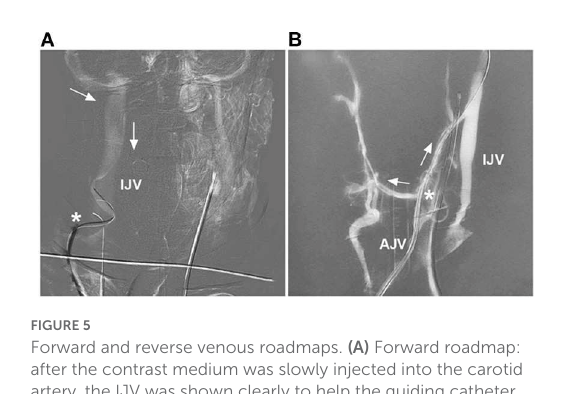
FIGURE5 Forward and reverse venous roadmaps. (A) Forward roadmap: after the contrast medium was slowly injected into the carotid artery, the IJV was shown clearly to help the guiding catheter (asterisk) navigate in the IJV, and the arrows indicate the direction of blood flow. (B) Reverse roadmap: immediately after the guiding catheter (asterisk) injected the contrast medium into the AJV, the AJV and nearby veins were shown clearly, and the arrows indicate the direction of blood flow. AJV, anterior jugular vein; IJV, internal jugular vein.